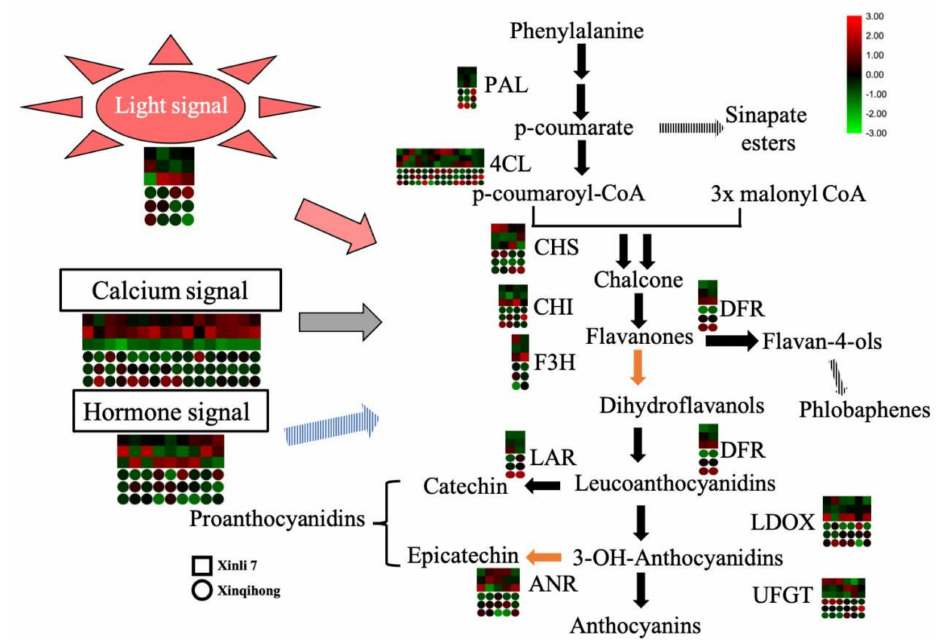
Figure 4. Signaling mechanisms regulating the distinct coloration patterns of ‘Xinli 7 (cid:48) and ‘Xinqihong’ red pear